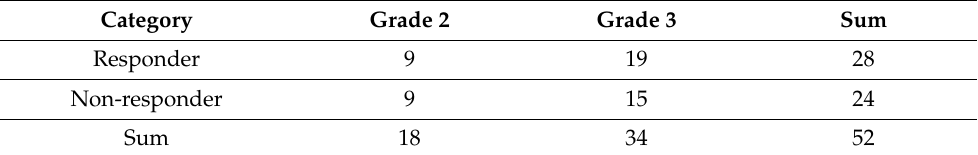
Table 5. Distribution of therapy responders and non-responders in patients with soft-tissue sarcomas grade 2 or grade